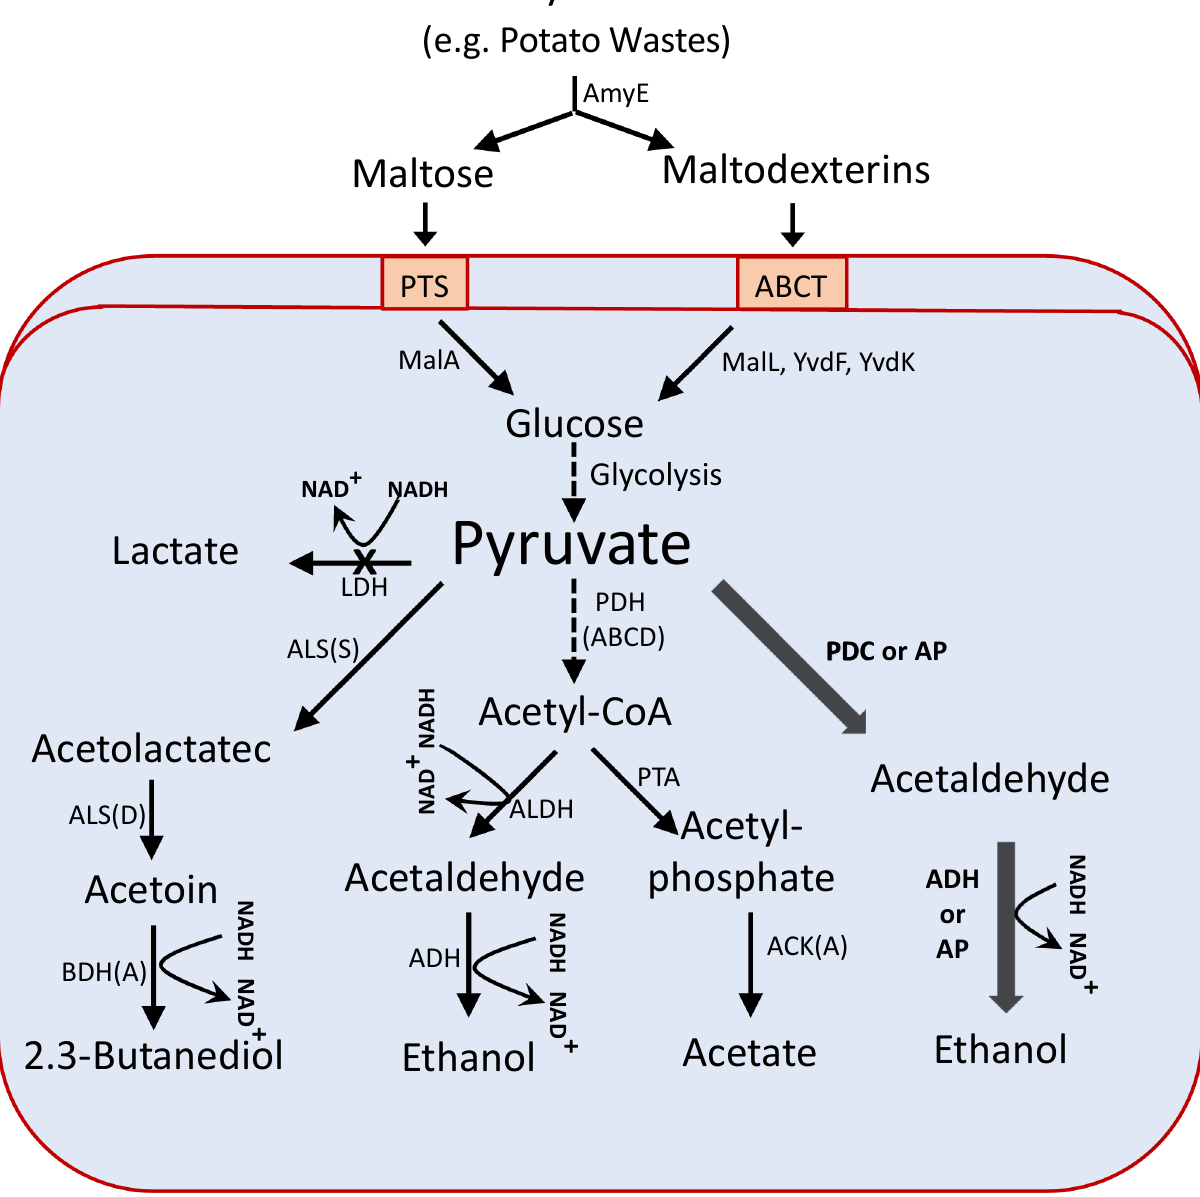
Figure 1. Schematic representation of B. subtilis fermentation metabolism and ethanol production from potatoes using the engineered heterologous pathways. The thin arrows indicate the intrinsic metabolic pathways and the thick arrows point to the engineered pathway composed of either PDC and ADH or the bifunctional AP fusion. AmyE extracellular amylase, PTS phosphotransferase system, MalA phospho-α-1,4-glucosidase, ABCT ABC transporter, YvdF maltogenic amylase, YvdK maltose phosphorylase, MalL glucosidase, LDH lactate dehydrogenase, ALS acetolactate synthase; BDH butanediol dehydrogenase, PDH pyruvate dehydrogenase, ALDH acetaldehyde dehydrogenase, PTA phosphotransacetylase, ACK acetate kinase, PDC pyruvate decarboxylase, ADH alcohol dehydrogenase, AP bifunctional AHD:PDC